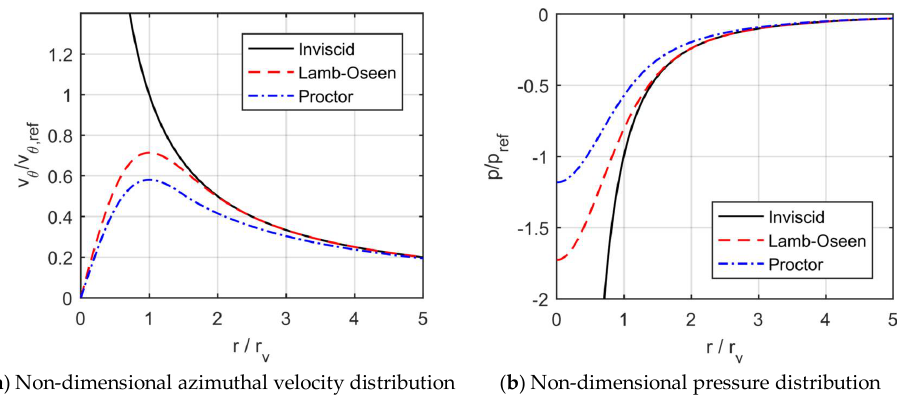
Figure 2. Comparison between various vortex models. The reference values are taken from the values for the inviscid vortex at r = r v